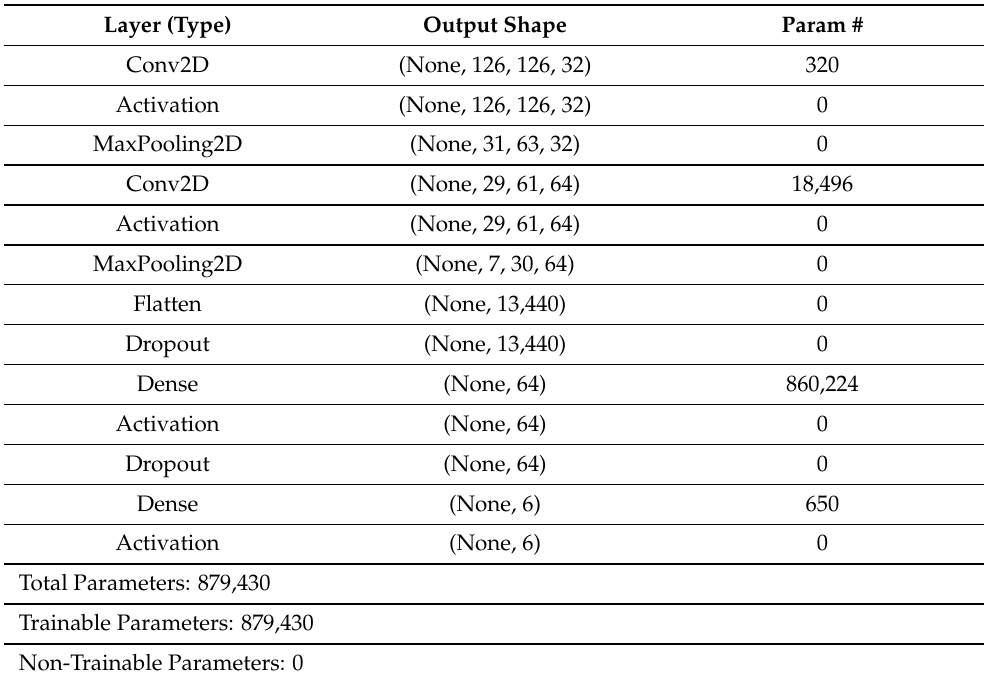
Table 3. FDC-2 Model Hyper